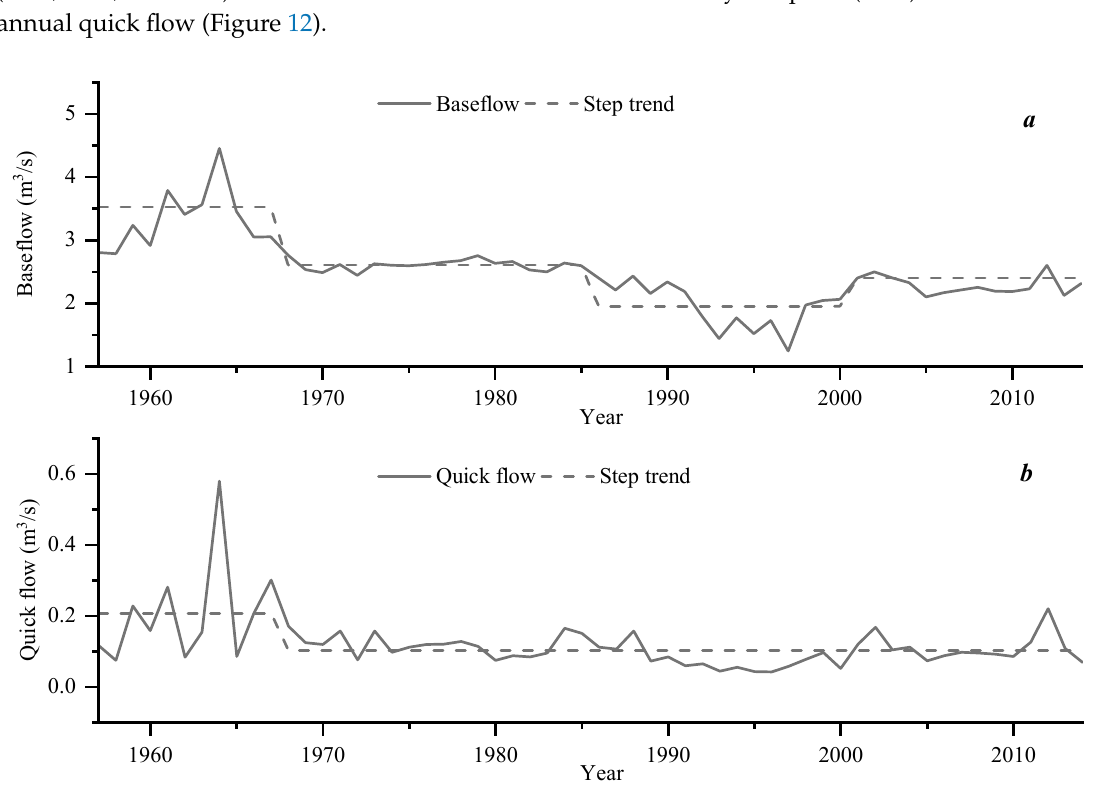
Figure 12. Flow regime shifts ( a ) annual mean baseflow and ( b ) annual mean quick flow.